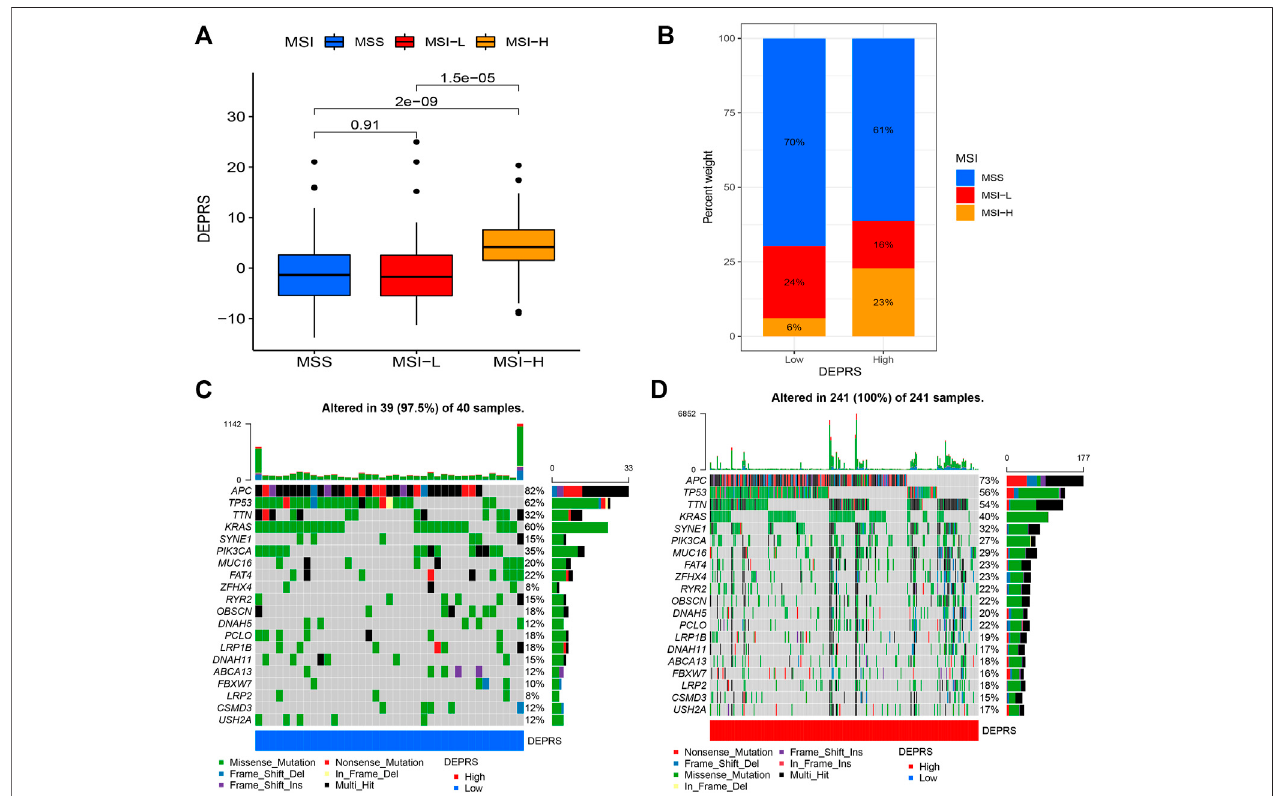
FIGURE 6 | (A) The pro fi le of DEPSR among different MSI status. The Kruskal-Wallis test was adopted to make statistical comparisons between different MSI status ( p < 0.001). (B) Proportion of patients with different MSI status in high DEPES and low DEPRS groups. The proportion of MSS and MSI-L patients in the low DEPRSgroupwassigni fi cantlylowerthanthatinthehighDEPRS( p < 0.05).ThegroupswerecomparedusingtheKruskal-Wallistest. (C,D) Awaterfalldiagramshowing the top 20 driver genes with the highest mutation frequency in low DEPRS (C) and high DEPRS (D) groups.